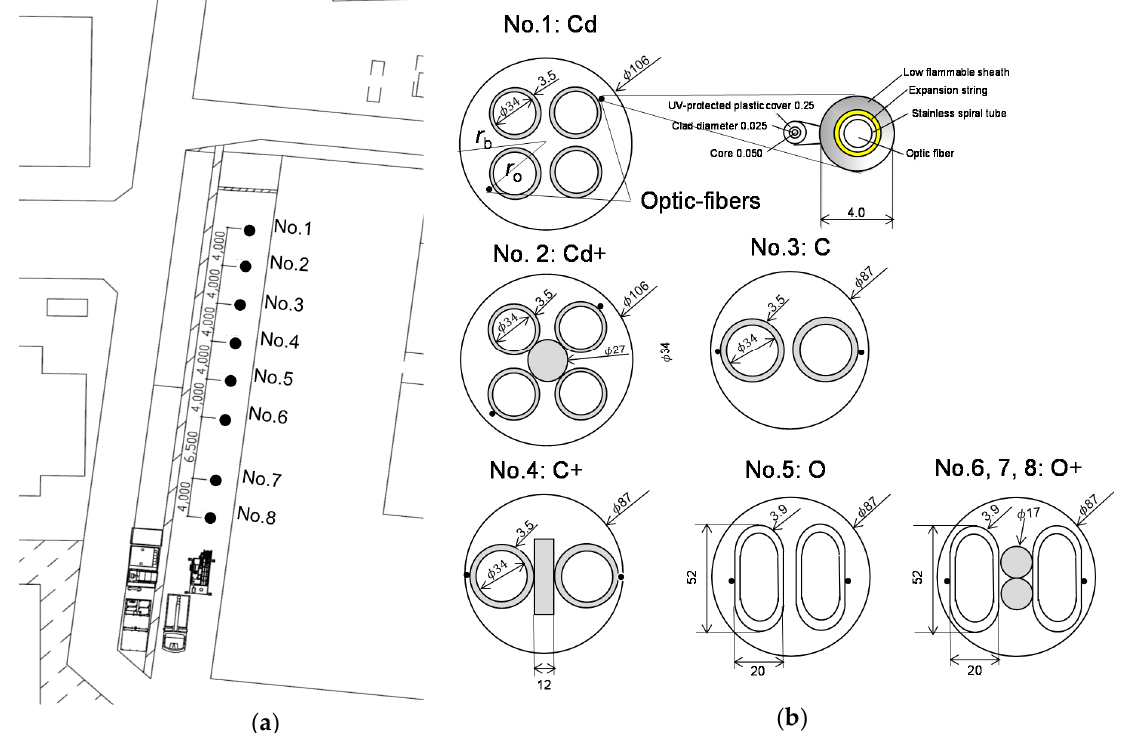
Figure 2. ( a ) Arrangement and ( b ) cross-sections of eight borehole heat exchangers (BHEs) aligned mainly at 4 m inter-